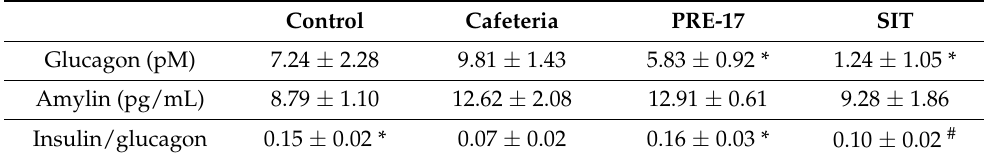
Table 2. Plasma and tissue parameters at the sacrifice of rats treated for 17 weeks with cafeteria diet with/without a 10-day pre-treatment with GSPE or a synchronic treatment with GSPE. Animals were sacrificed under a light fast of 3 h.